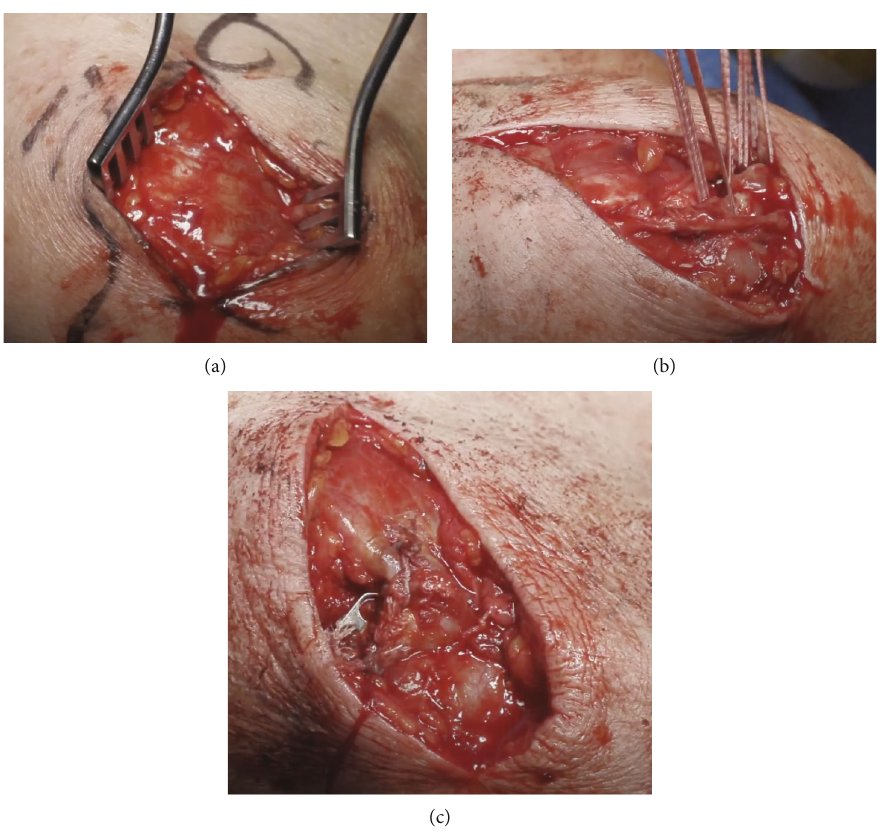
Figure 4: (a) Intact fascia directly overlying the torn right deltoid muscle. (b) Deltoid muscle secured by strong resorbable sutures (FiberTape sutures x3 [Arthrex, Naples, FL.]) passed in a Mason Allen con fi guration. (c) Deltoid repair after sutures were tied over a 3- hole mini plate (Stryker, Kalamazoo, MI) on the superior surface of the